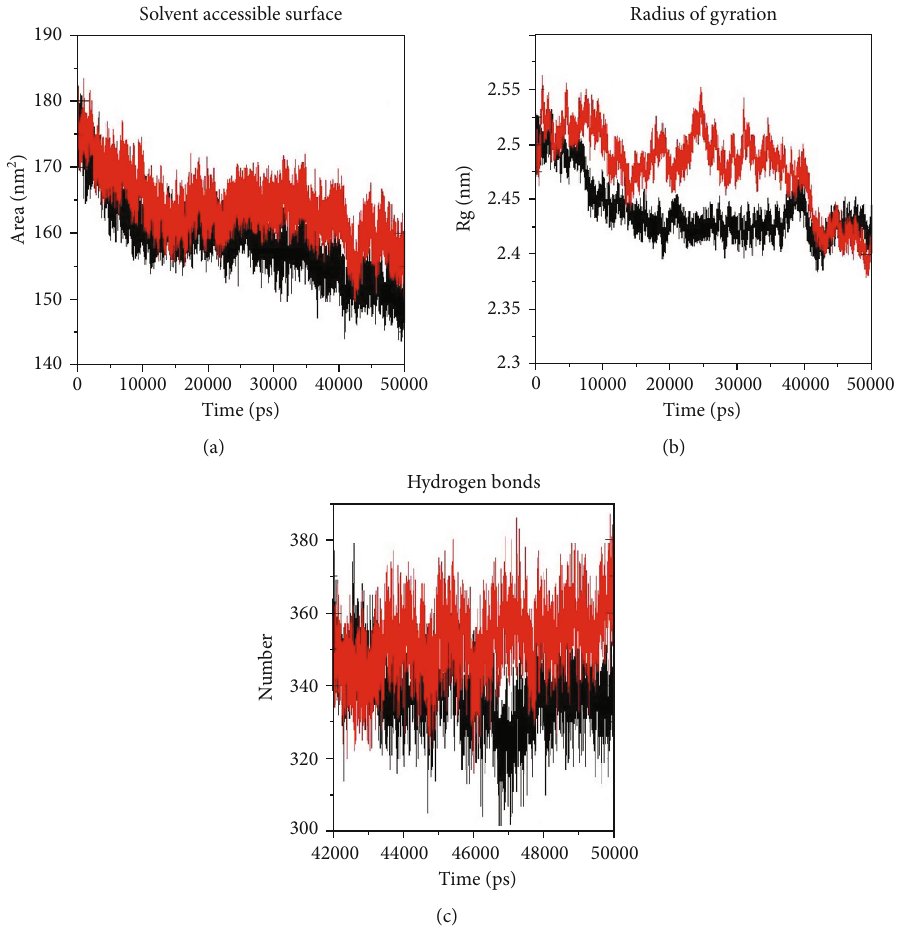
Figure 3: GROMACS analysis of Rg, SASA, and intramolecular hydrogen bonds of C α atoms for the mutant and wild type in the PPAR γ 2 protein at 300 K. (a) Rg, (b) SASA, and (c) intramolecular hydrogen bonds. Mutant was shown in black and wild type in